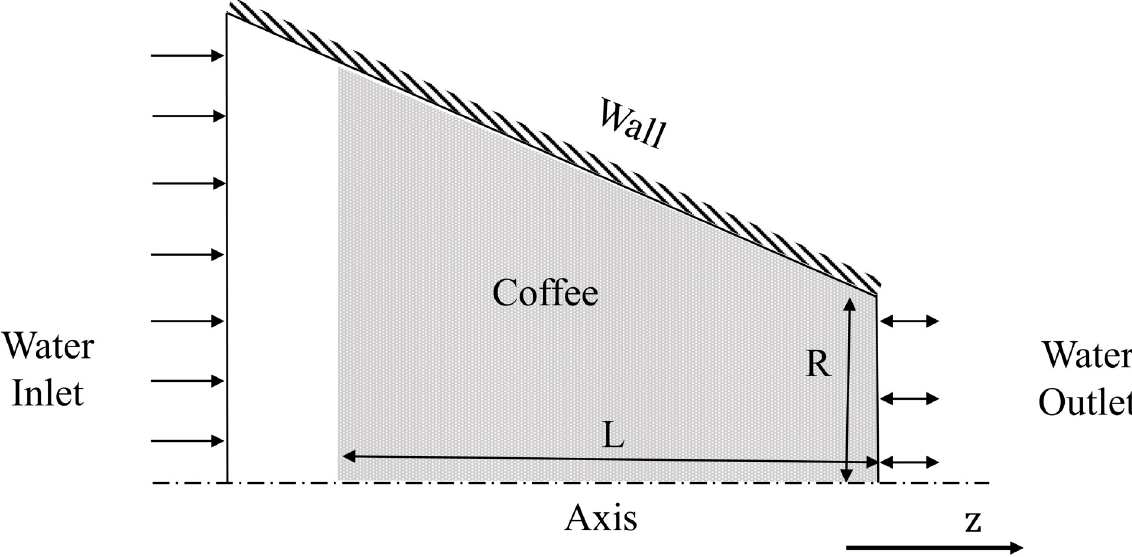
Fig 5. Conical case computational domain. Conical case computational domain with included boundary